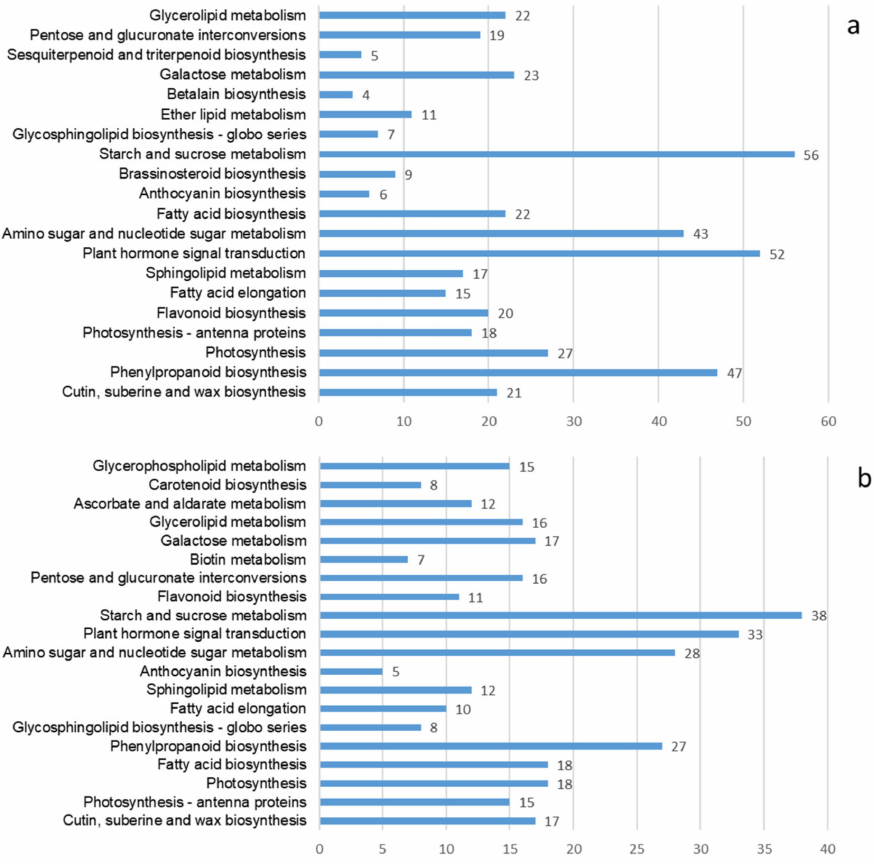
Figure 4. Annotation analysis of the KEGG pathway of differentially expressed genes in ginkgo leaves treated with Na 2 SeO 3 . ( a ) Group A vs. CK; ( b ) group B vs. CK. Note: CK control group; A—foliar spraying; B—root